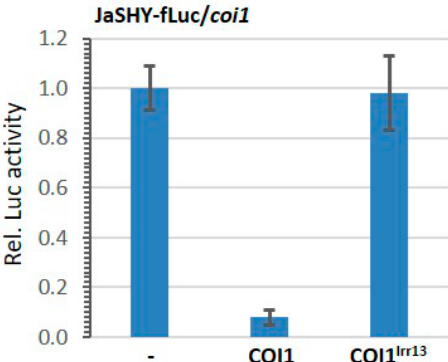
Figure 3. The expression of protein-fusion reporter JaSHY-fLuc was reduced by COI1 in coi1 protoplasts. Arabidopsis leaf protoplasts prepared from coi1 mutant plants were co-transfected with protein-fusion reporter plasmid encoding JaSHY-fLuc under the control of UBQ10 promoter and effector plasmids encoding COI1 or COI1 lrr13 under the control of UBQ10 promoter. Firefly luciferase (fLuc) activities were normalized to Renilla luciferase (rLuc) activities. Reporter activities of JaSHY-fLuc without effector vector were set to one. Values represent means (±SE) of four independently transformed batches of protoplasts.